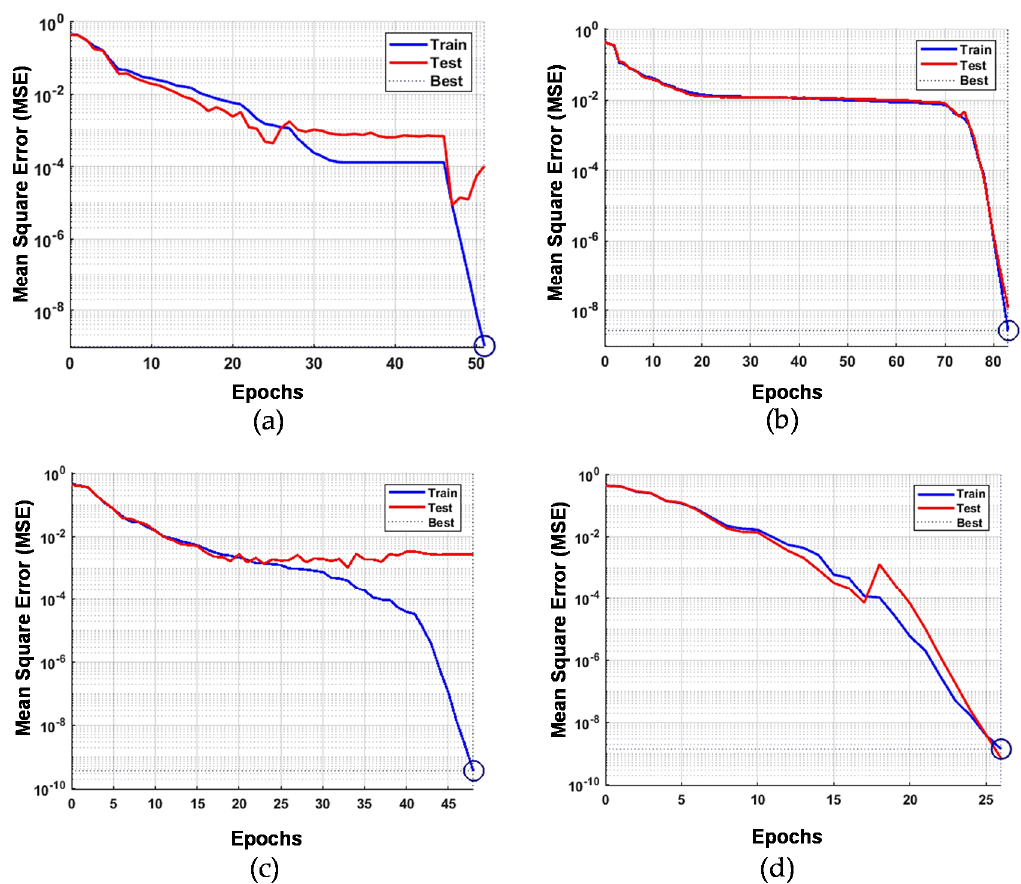
Figure 5. ANN performance at investigated extracted signal (( a ) complete response curve; ( b ) rise period; ( c ) intermediate period; ( d ) peak period) with respects to mean square error versus the number of epochs. Table 11. Classification accuracy rate results with ANN application and validation dataset.